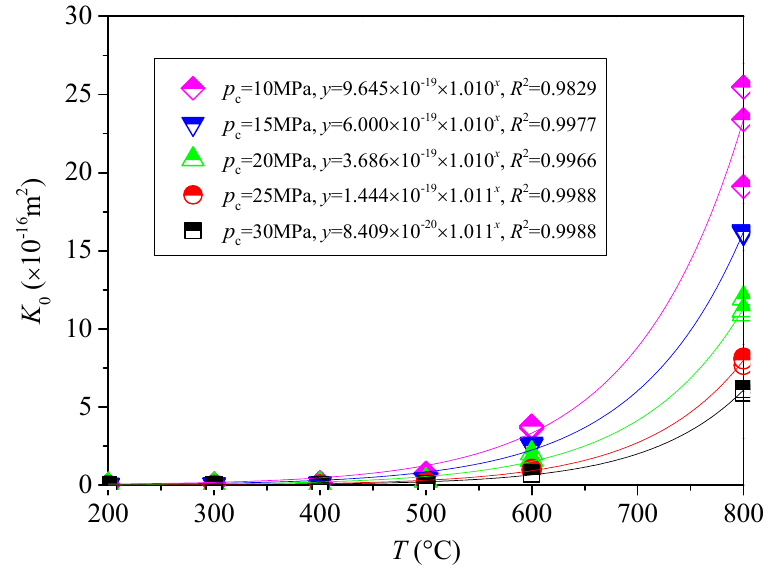
Figure 7. Variation in the equivalent permeability coefficients of granite samples with temperature.